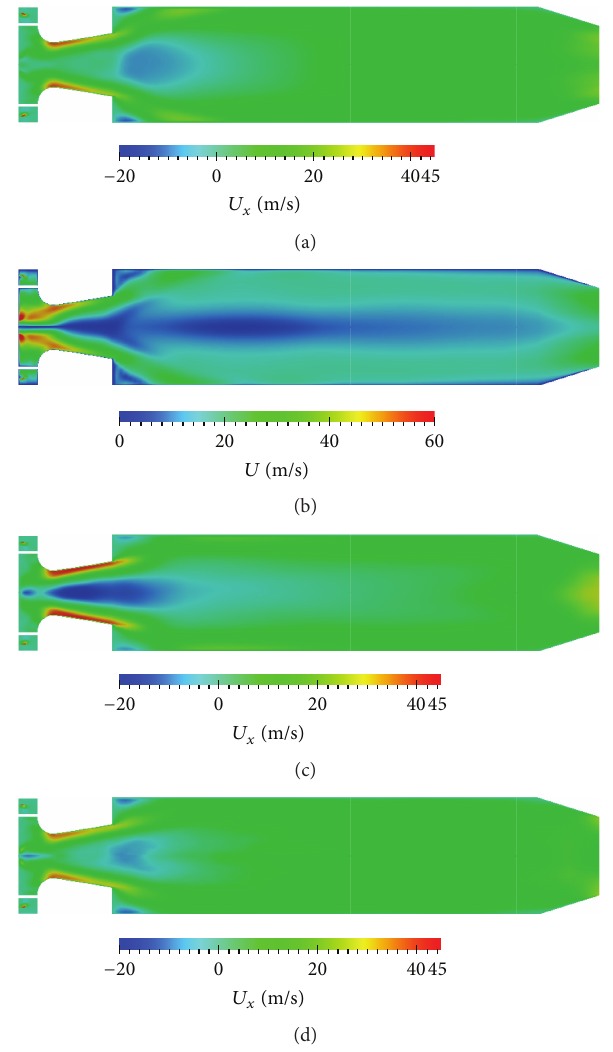
Figure 7: Predicted time-averaged velocity fields in a plane through combustor for NG-FGR20 flame: (a) axial velocity URANS-SST, (b) velocity magnitude URANS-SST, (c) axial velocity URANS-RSM, and (d) axial velocity LES.